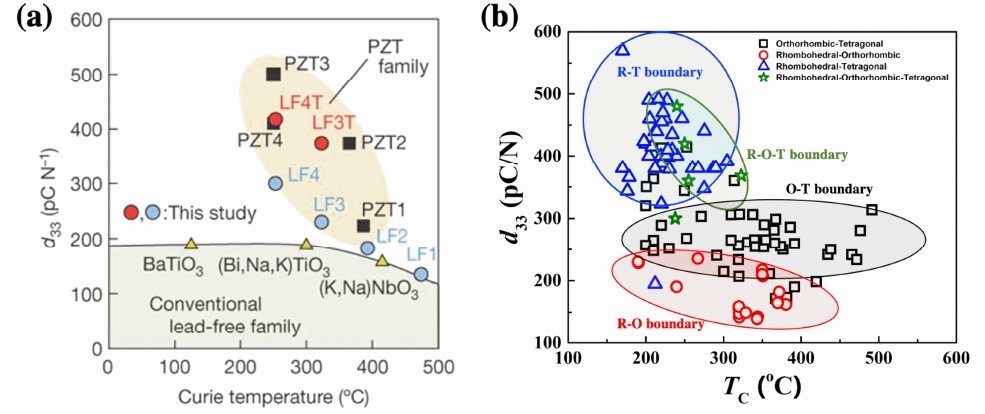
Figure 4. Piezoelectric coefficient d 33 versus Curie temperature. ( a ) Comparison between the devel- oped (K 0.44 Na 0.52 Li 0.04 )(Nb 0.86 Ta 0.10 Sb 0.04 )O 3 (LF) ceramics and the conventional PZT ceramics. Reprinted with the permission of [46]. Copyright © 2004 Springer Nature. ( b ) Comparison according to type of phase boundary in KNN-based ceramics.